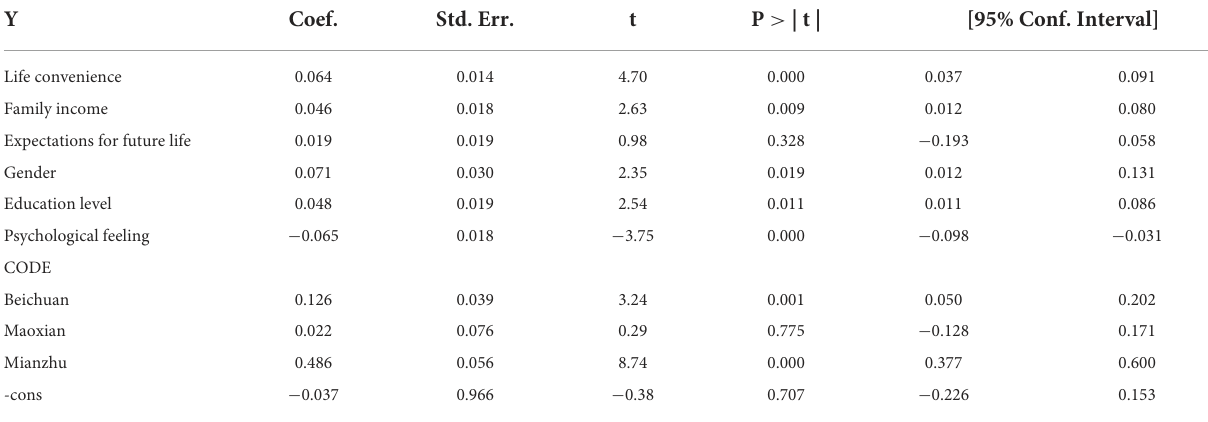
TABLE 6 Variables and willingness of residents affected to migration with district fixed effects. Y Coef. Std.